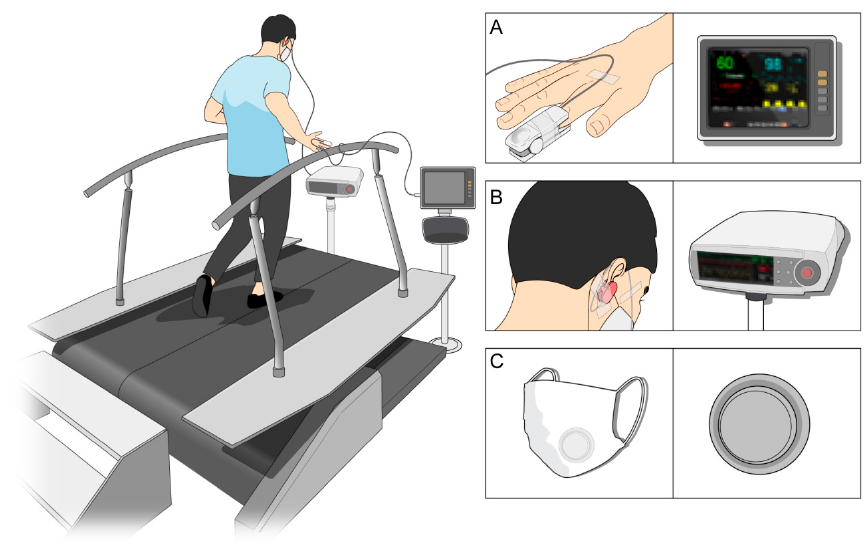
Figure 2. Schematic drawing of the data acquisition system. ( A ) Infrared transcutaneous sensor attached to the fingertip to measure peripheral oxygen saturation and heart rate; ( B ) transcutaneous monitoring sensor applied to the earlobe to measure partial pressure of carbon dioxide; ( C ) portable temperature and humidity data logger attached inside the mask.